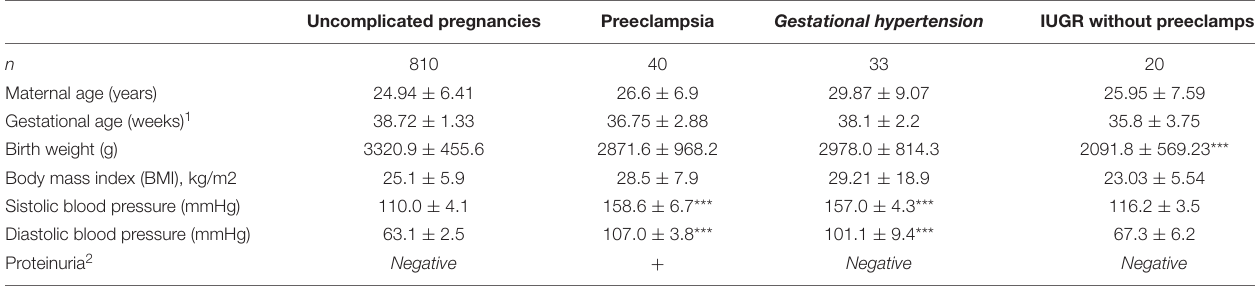
TABLE 1 | Clinical Characteristics of the studied